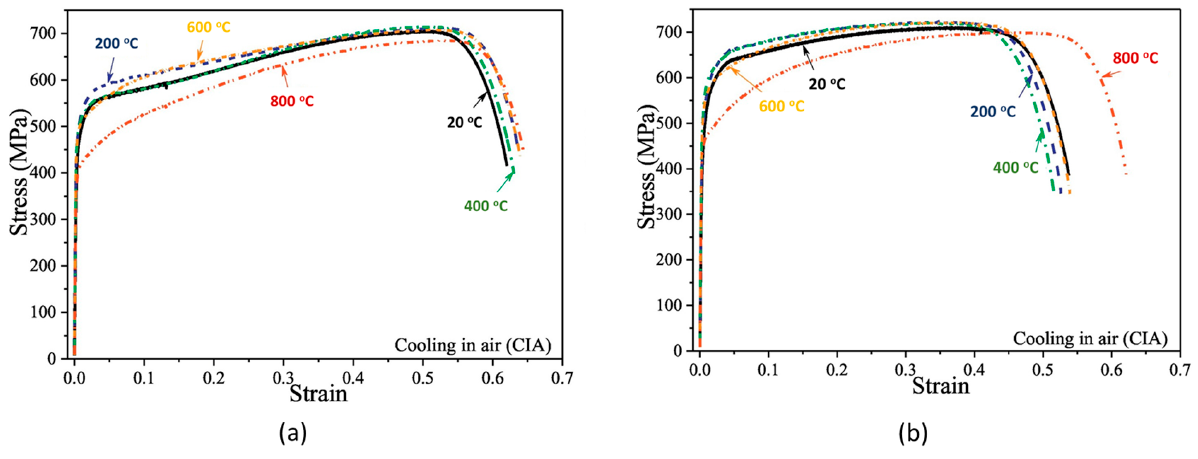
Figure 8. Stress–strain curves for ( a ) grade A2–70 and ( b ) grade A4–70 stainless-steel bolts exposed to high temperatures